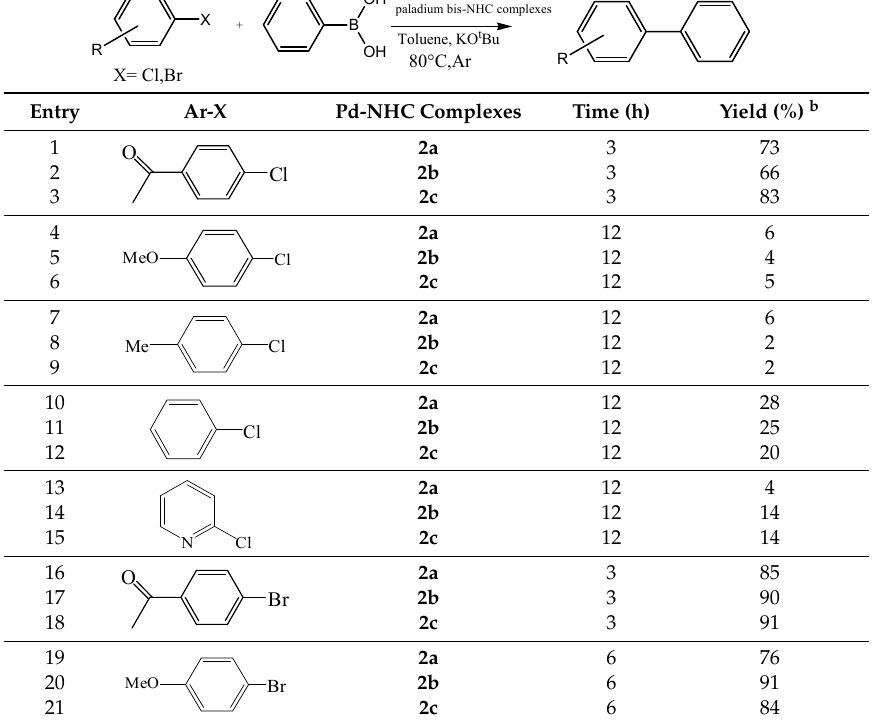
Table 2. The Suzuki coupling reaction of aryl chlorides/bromides with phenylboronic acid catalyzed by different unsymmetrical palladium-bis-NHCs complexes a .